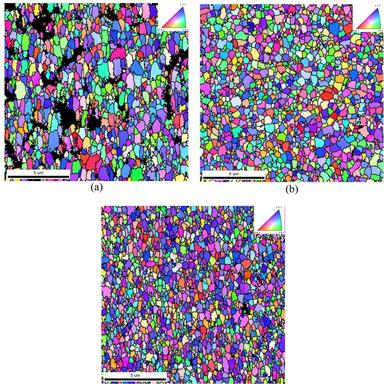
Electron backscatter diffraction inverse pole figure (EBSD-IPF) map of: (a) Al-based, (b) Al-25AlN, and (c) Al-25AlN-4Mg alloy-structured specimens.